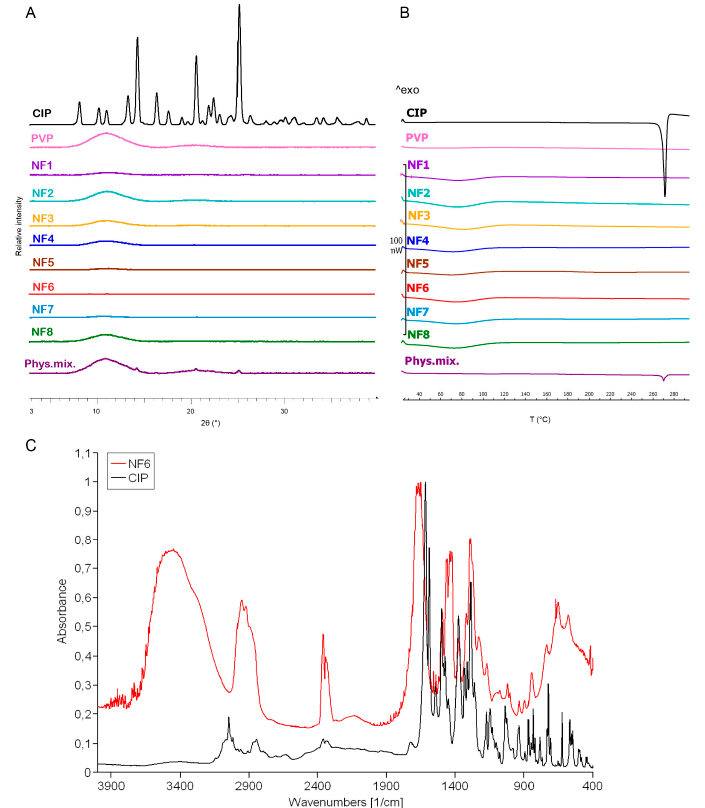
Figure 3. XRPD diffractogram ( A ) and DSC thermograms ( B ) of ciprofloxacin (CIP), PVP, physical mixture, and NF1–NF8 nanofibrous samples. All the electrospun samples are amorphous solid dispersions. FTIR spectra ( C ) of CIP and NF6 nanofi- brous sample. The observed shifts and widenings confirm the successful incorporation of the CIP into the polymeric